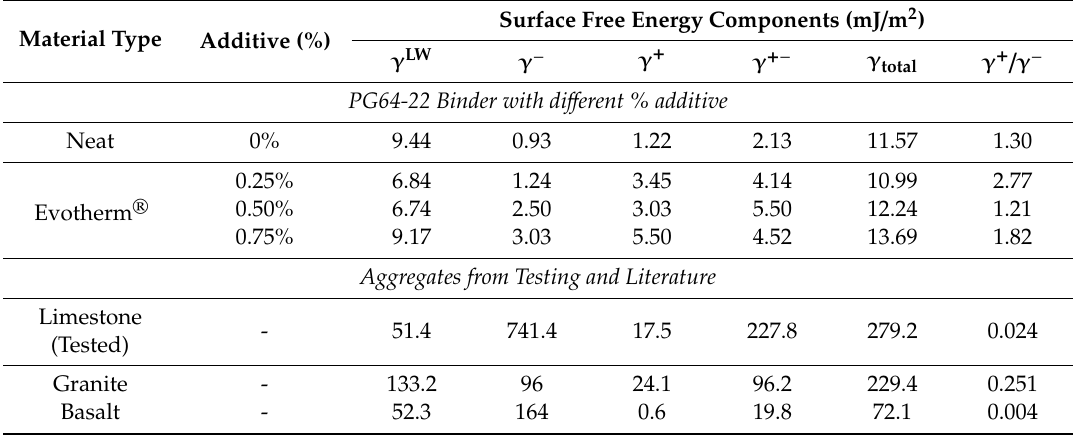
Table 2. SFE components of PG64-22 asphalt binder modified with Evotherm ® and aggregates (Reprinted with permission from [43]. Copyright (2013), with permission from Elsevier). γ LW : LW component. γ − : Lewis base component. γ + : Lewis acid component. γ + − = 2 component. γ total : total surface free energy of the